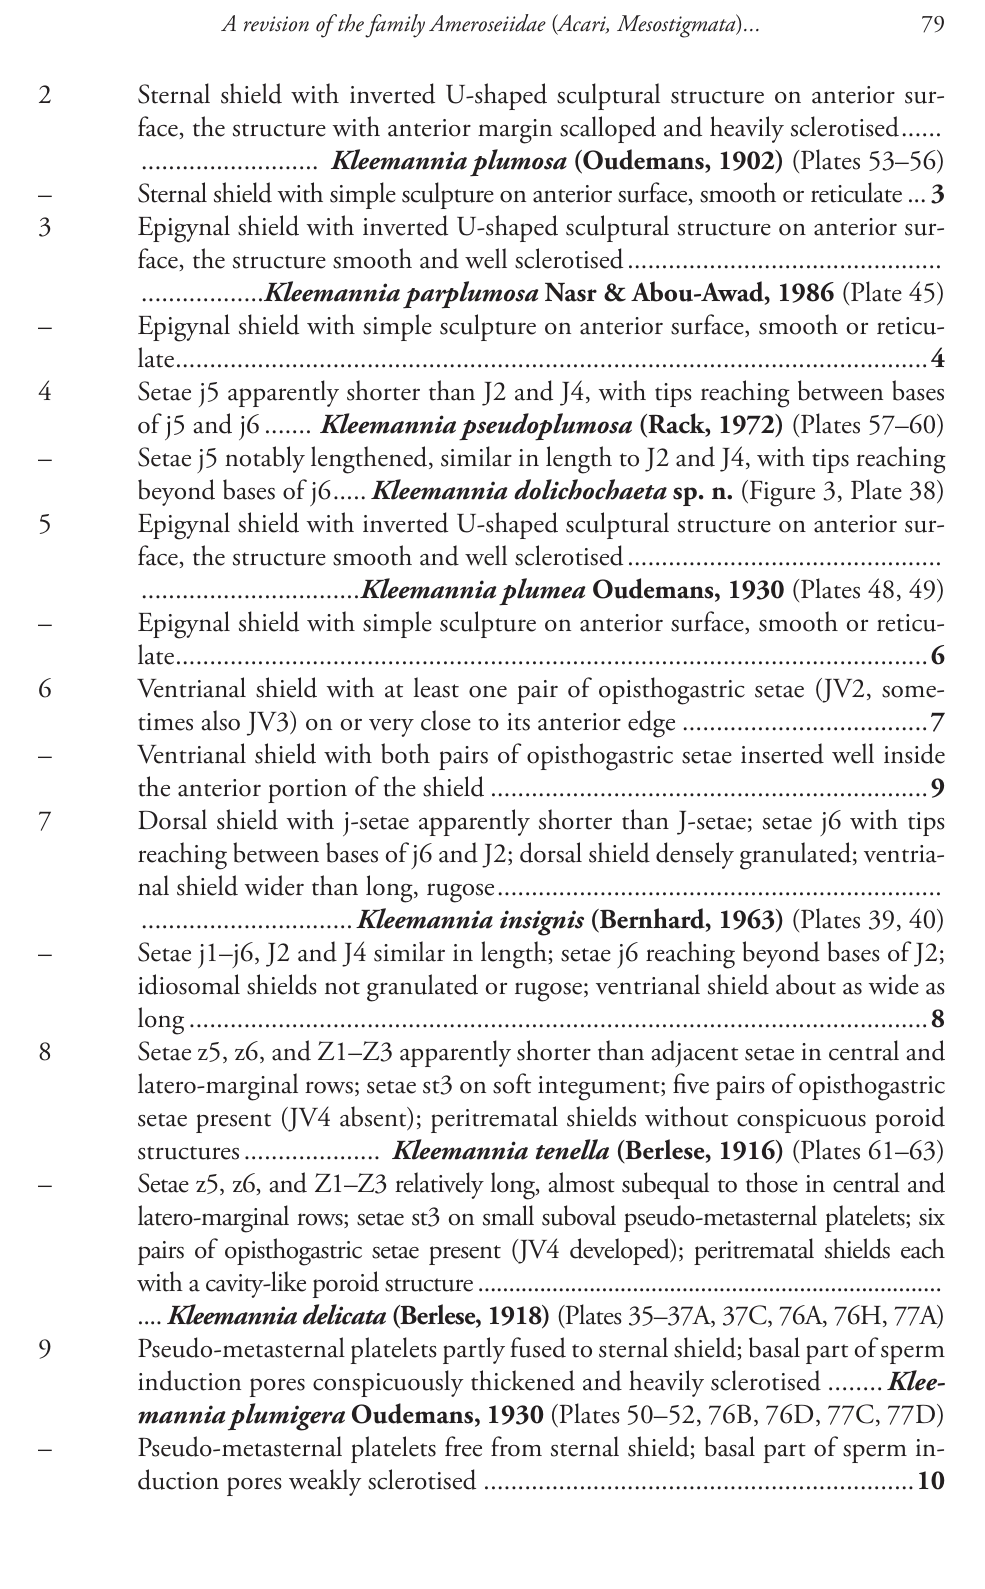
Sternal shield with inverted U-shaped sculptural structure on anterior sur- face, the structure with anterior margin scalloped and heavily sclerotised ...... – Sternal shield with simple sculpture on anterior surface, smooth or reticulate ... 3 3 Epigynal shield with inverted U-shaped sculptural structure on anterior sur- face, the structure smooth and well sclerotised .............................................. – Epigynal shield with simple sculpture on anterior surface, smooth or reticu- 4 Setae j5 apparently shorter than J2 and J4, with tips reaching between bases of j5 and j6 ....... Kleemannia pseudoplumosa (Rack, 1972) (Plates 57–60) – Setae j5 notably lengthened, similar in length to J2 and J4, with tips reaching beyond bases of j6 ..... Kleemannia dolichochaeta sp. n. (Figure 3, Plate 38) 5 Epigynal shield with inverted U-shaped sculptural structure on anterior sur- face, the structure smooth and well sclerotised .............................................. – Epigynal shield with simple sculpture on anterior surface, smooth or reticu- 6 Ventrianal shield with at least one pair of opisthogastric setae (JV2, some- times also JV3) on or very close to its anterior edge .................................... 7 – Ventrianal shield with both pairs of opisthogastric setae inserted well inside the anterior portion of the shield ................................................................ 9 7 Dorsal shield with j-setae apparently shorter than J-setae; setae j6 with tips reaching between bases of j6 and J2; dorsal shield densely granulated; ventria- nal shield wider than long, rugose ................................................................. – Setae j1–j6, J2 and J4 similar in length; setae j6 reaching beyond bases of J2; idiosomal shields not granulated or rugose; ventrianal shield about as wide as long ............................................................................................................ 8 8 Setae z5, z6, and Z1–Z3 apparently shorter than adjacent setae in central and latero-marginal rows; setae st3 on soft integument; five pairs of opisthogastric setae present (JV4 absent); peritrematal shields without conspicuous poroid structures .................... Kleemannia tenella (Berlese, 1916) (Plates 61–63) – Setae z5, z6, and Z1–Z3 relatively long, almost subequal to those in central and latero-marginal rows; setae st3 on small suboval pseudo-metasternal platelets; six pairs of opisthogastric setae present (JV4 developed); peritrematal shields each with a cavity-like poroid structure ........................................................................... .... Kleemannia delicata (Berlese, 1918) (Plates 35–37A, 37C, 76A, 76H, 77A) 9 Pseudo-metasternal platelets partly fused to sternal shield; basal part of sperm induction pores conspicuously thickened and heavily sclerotised ........ Klee- mannia plumigera Oudemans, 1930 (Plates 50–52, 76B, 76D, 77C, 77D) – Pseudo-metasternal platelets free from sternal shield; basal part of sperm in- duction pores weakly sclerotised ...............................................................